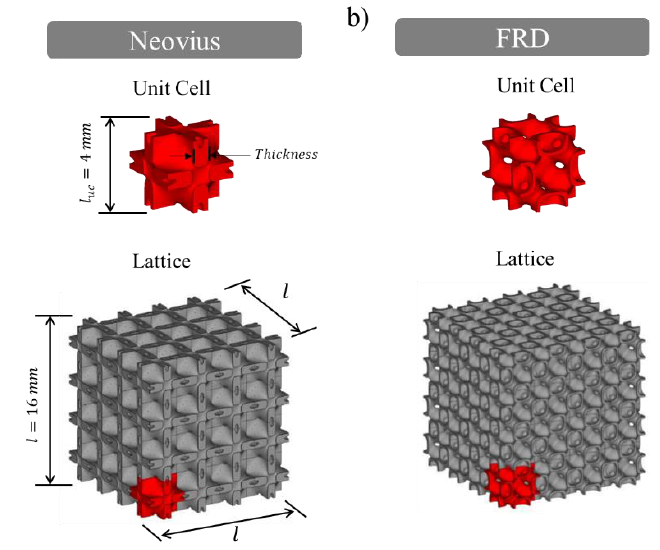
Fig. 1. 3D CAD models of single unit cell and lattice structures of a) Neovius and b) FRD TPMS topologies.